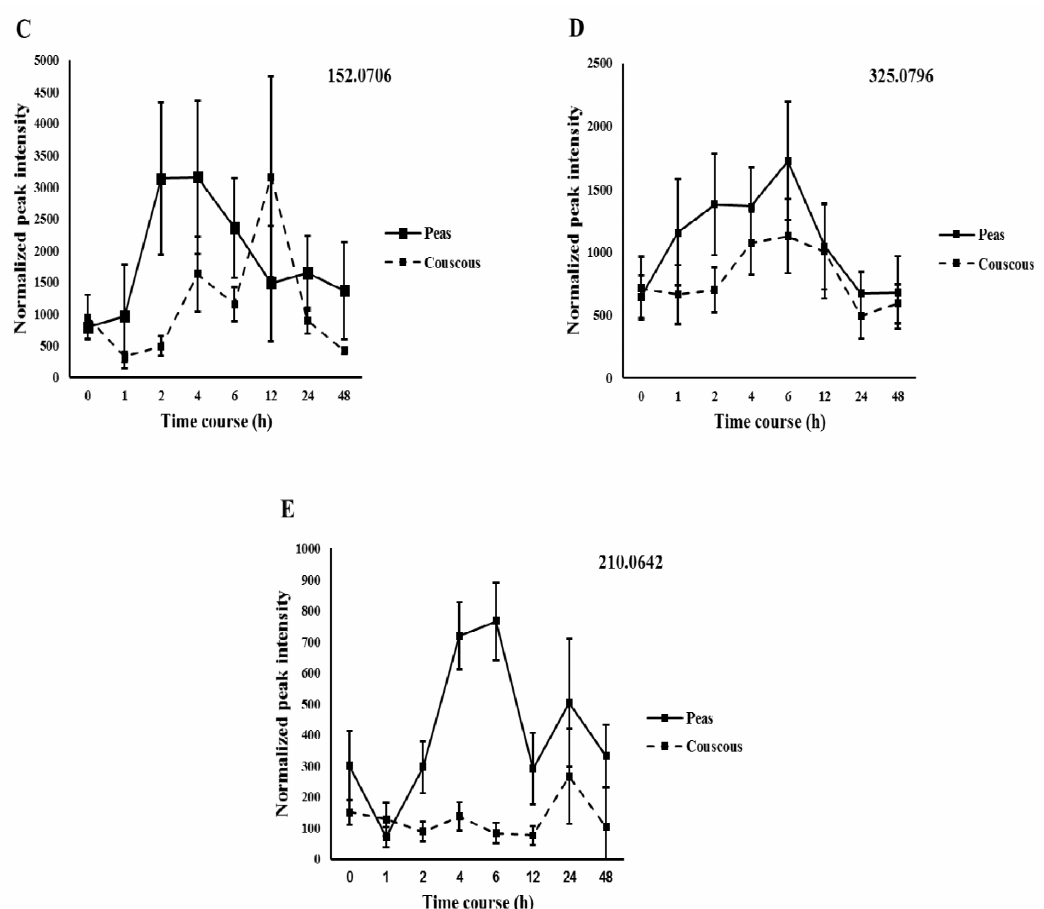
Figure 3. Kinetics of the selected discriminating positive ion mode features obtained from the discovery study represented with accurate mass (231.1221 ( A ); 168.0288 ( B ); 152.0706 ( C ); 325.0796 ( D ); and 210.0642 ( E )) after pea intake and compared with control food couscous ( p < 0.05). Values are mean ± SEMs. X-axis values represent time course in hours and Y-axis values represent osmolality normalized peak intensity.